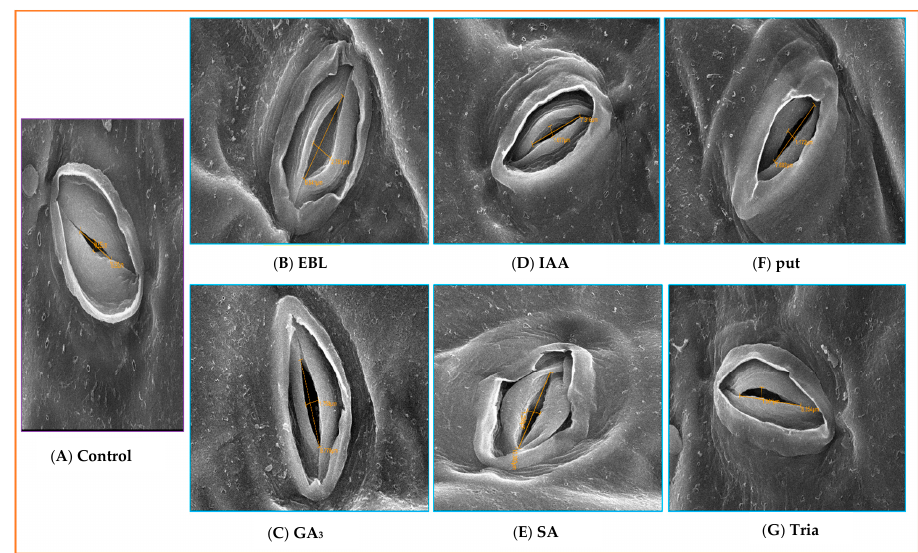
Figure 6. Scanning electron microscope images (at 4000× magnification) of the stomatal response of leaves of the Nath Sona mustard cultivar at 90 DAS. Results for the ( A ) Control and ( B – G ) plants treated with EBL, GA 3 , IAA, SA, put and Tria.